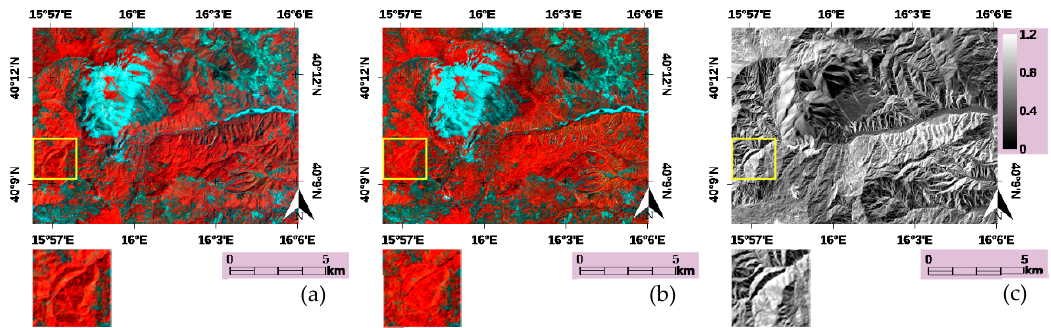
Figure 6. False color LANDSAT-8 images (R: 865 nm, G: 563 nm, B: 483 nm) before ( a ) and after ( b ) topographic correction; angle between the incoming solar radiation and the normal to the surface derived from the digital elevation model (DEM; c ).